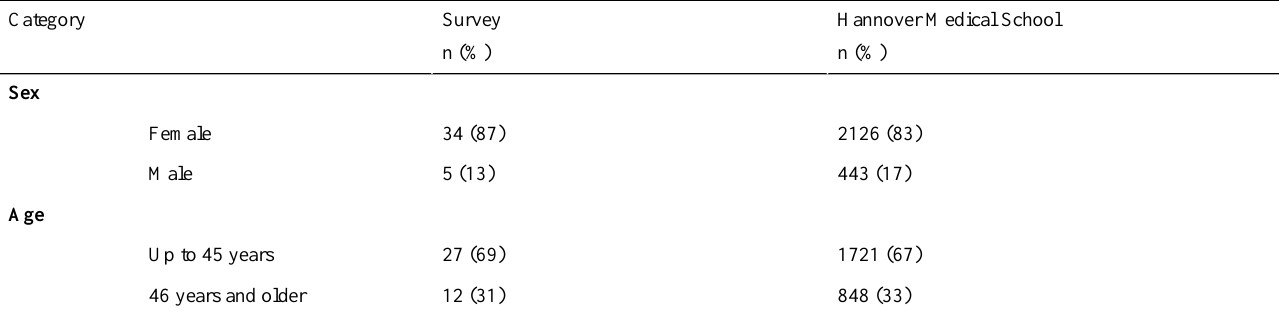
Table 2. Male-to-female ratio and age distribution in the final survey (N=39) and for the Hannover Medical School (N=2569, data for 2012 obtained from the human resources department).